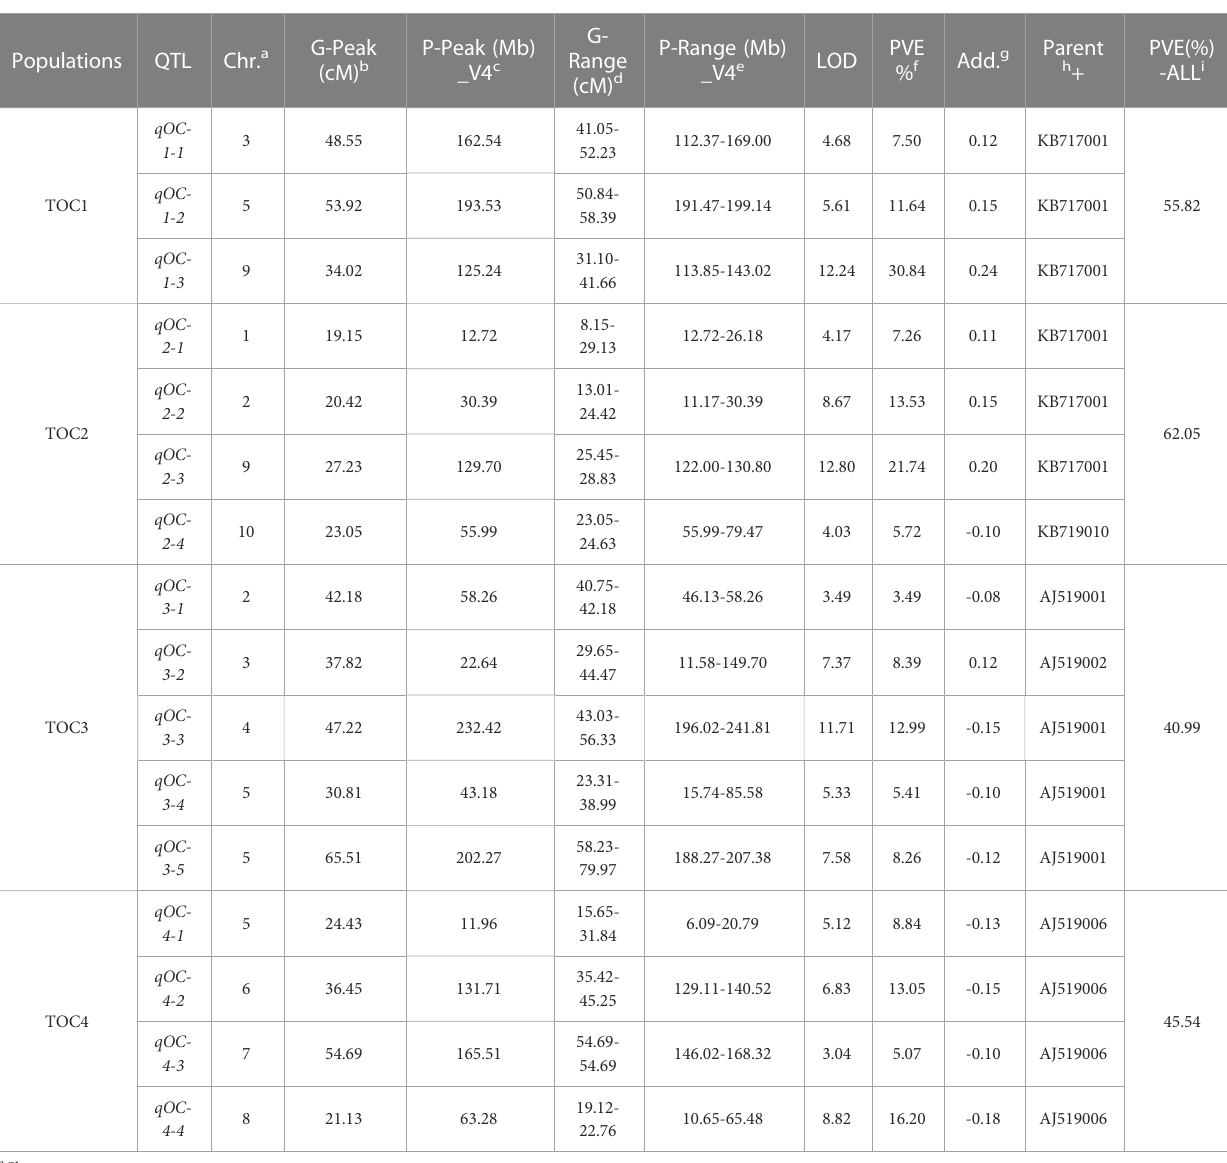
TABLE 2 Individual QTL for TOC in the four DH populations.